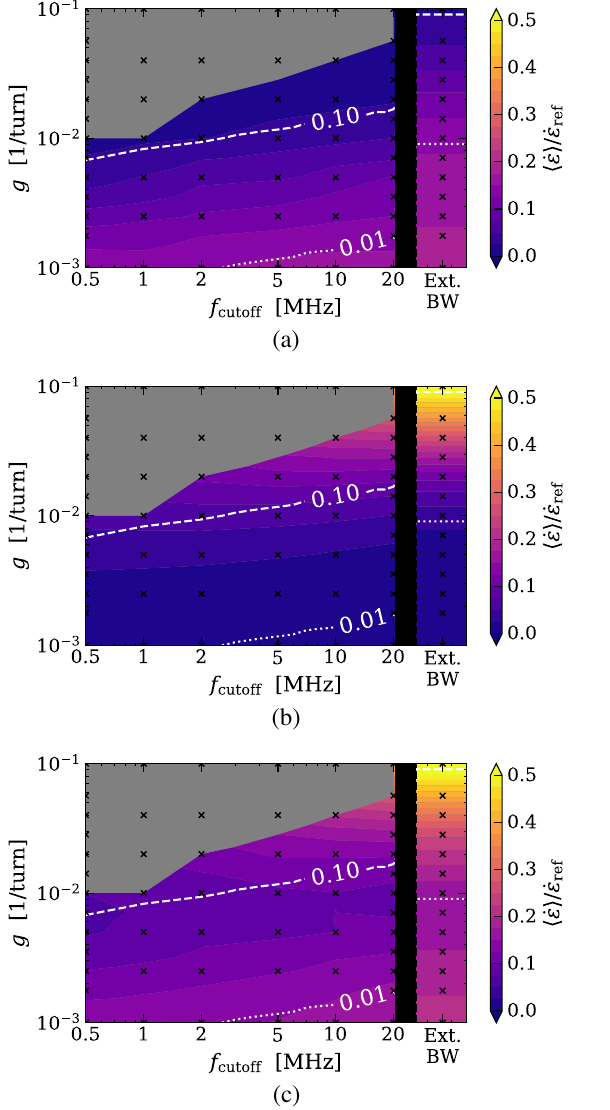
FIG. 7. Average emittance growth rate for 128 bunches sep- FIG. 6. Average emittance growth rate for 128 bunches sep- arated by 25 ns, due to LF noise in (a), BPM noise in (b), and both arated by 25 ns, due to LF noise in (a), BPM noise in (b), and both in (c), in a configuration with a beam-beam interaction and in (c), in a configuration with a beam-beam interaction and Q 0 ¼ 15 . The black crosses mark the simulations. The area Q 0 ¼ 0 . The black crosses mark the simulations. The area marked ; g Þ for which the marked gray contains configurations ð f ; g Þ for which the feedback gray contains configurations ð f cutoff cutoff feedback loop is unstable. The configurations at the edge of the loop is unstable. The configurations at the edge of the gray area gray area were stable. The white curves are contours of constant were stable. The white curves are contours of constant maximum ˜ N ˜ N maximum multibunch gain g . multibunch gain g